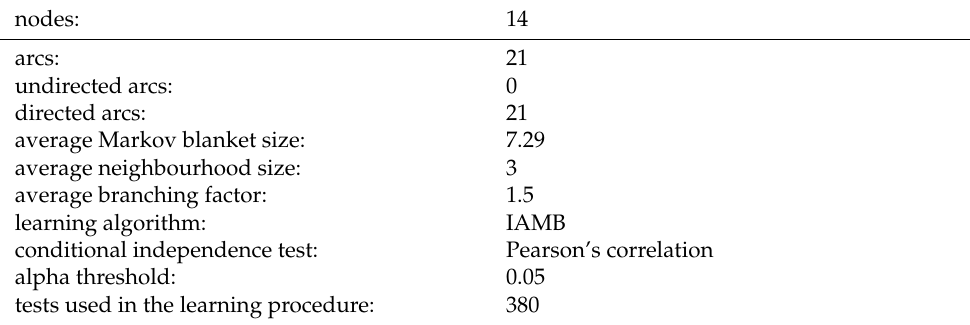
Table 2. BN model established with the use of IAMB algorithm.